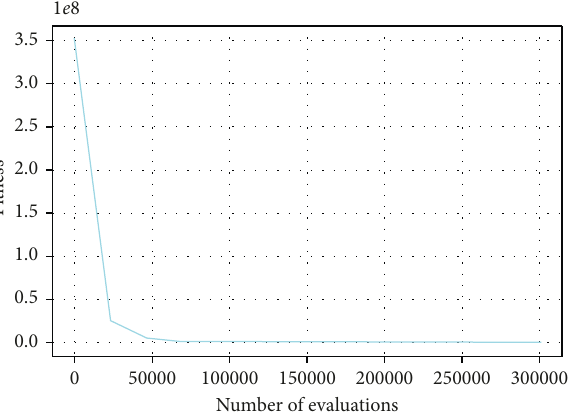
Figure 4: CEC14 Fun3 convergence